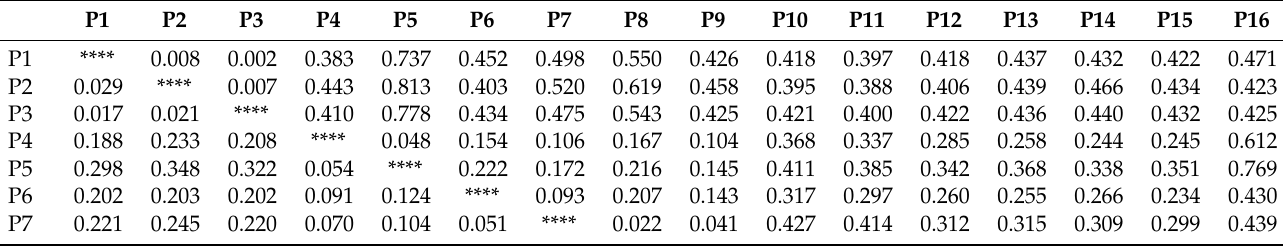
Table 4. Pairwise genetic differentiation index values (below the diagonal) and Nei’s genetic distance values (above the diagonal). **** indicates the diagonal division of the pairwise genetic differentiation index values and Nei’s genetic distance